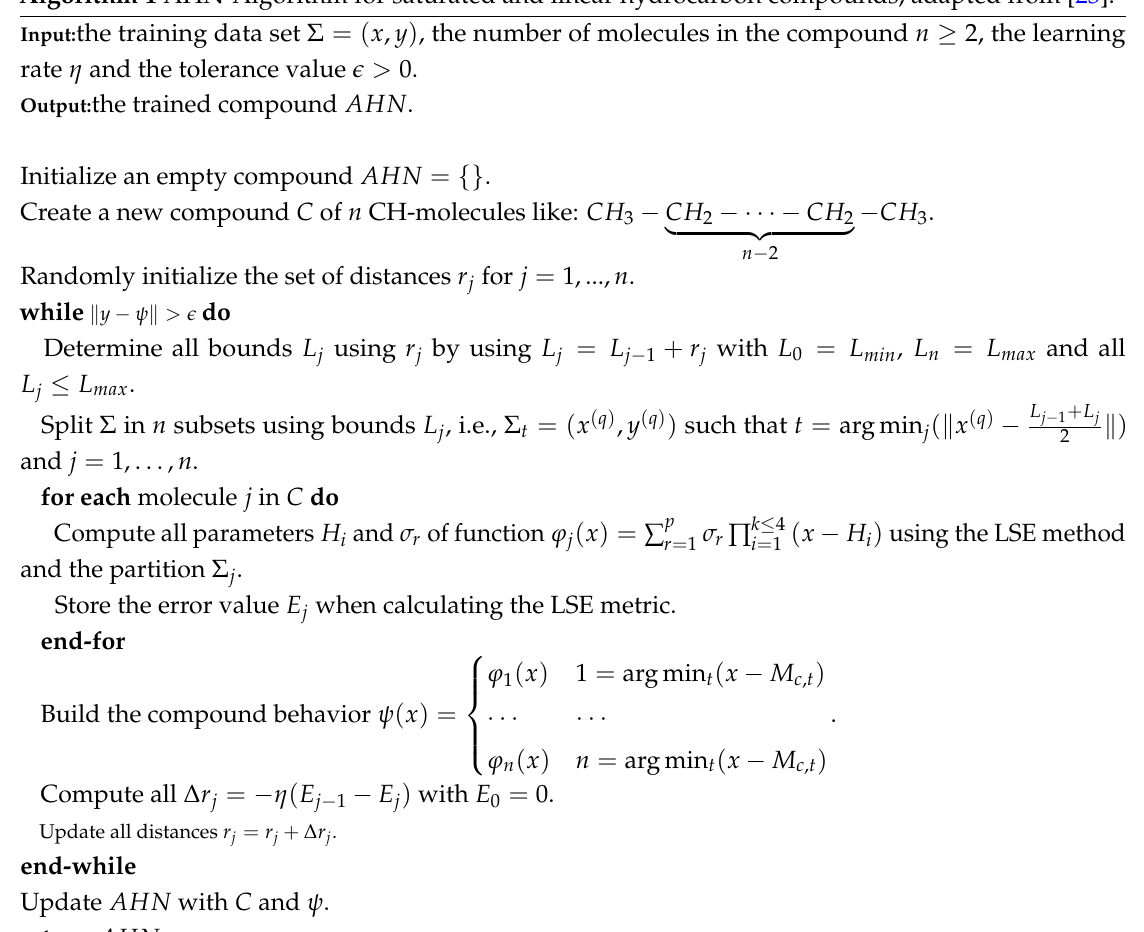
Algorithm 1 AHN-Algorithm for saturated and linear hydrocarbon compounds, adapted from